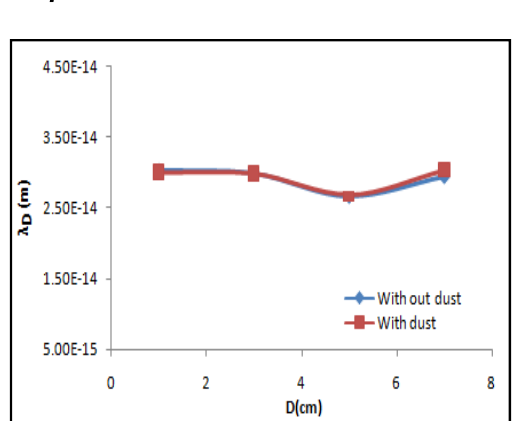
Fig.13: Debye length as a function of the Diameter position at different distances of the probes